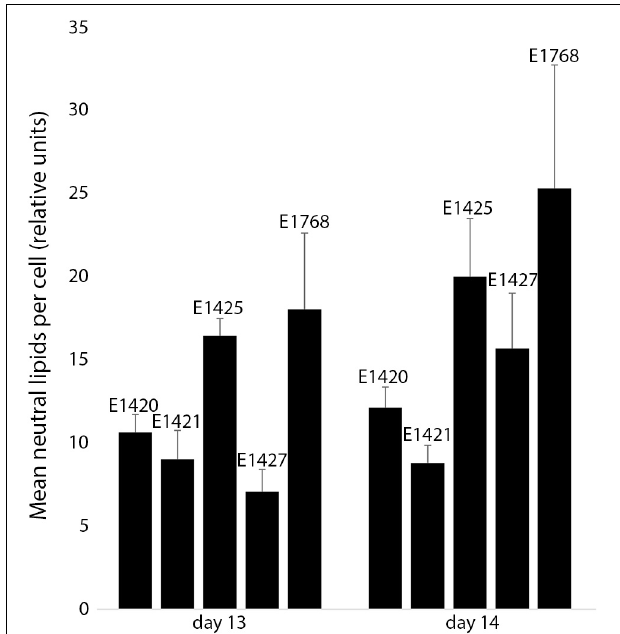
FIGURE 4 | The mean neutral lipid fluorescence in Schizostauron spp. strains measured using flow cytometer on day 13 ( n = 6 cultures) and day 14 ( n = 5 cultures) of the experiment. Error bars represent standard deviations.